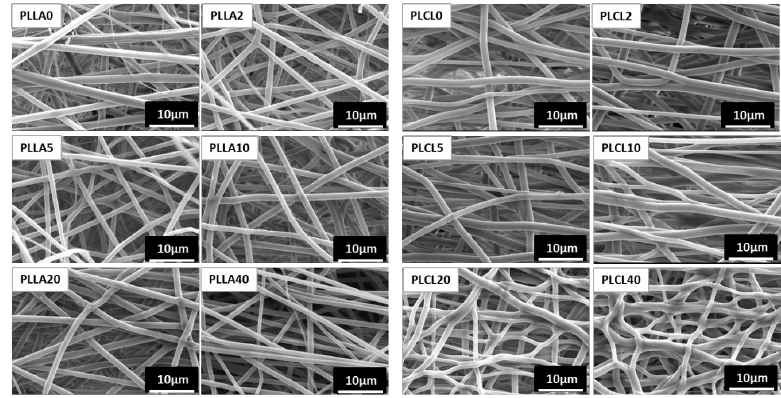
Figure 4. Morphology of electrospun bicomponent fibres with PGSu additive: PLLA2, PLLA5, PLLA10, PLLA20, and PLLA40 in relation to PLLA0 (pure PLLA), and PLCL2, PLCL5, PLCL10, PLCL20, and PLCL40 in relation to PLCL0 (pure PLCL).